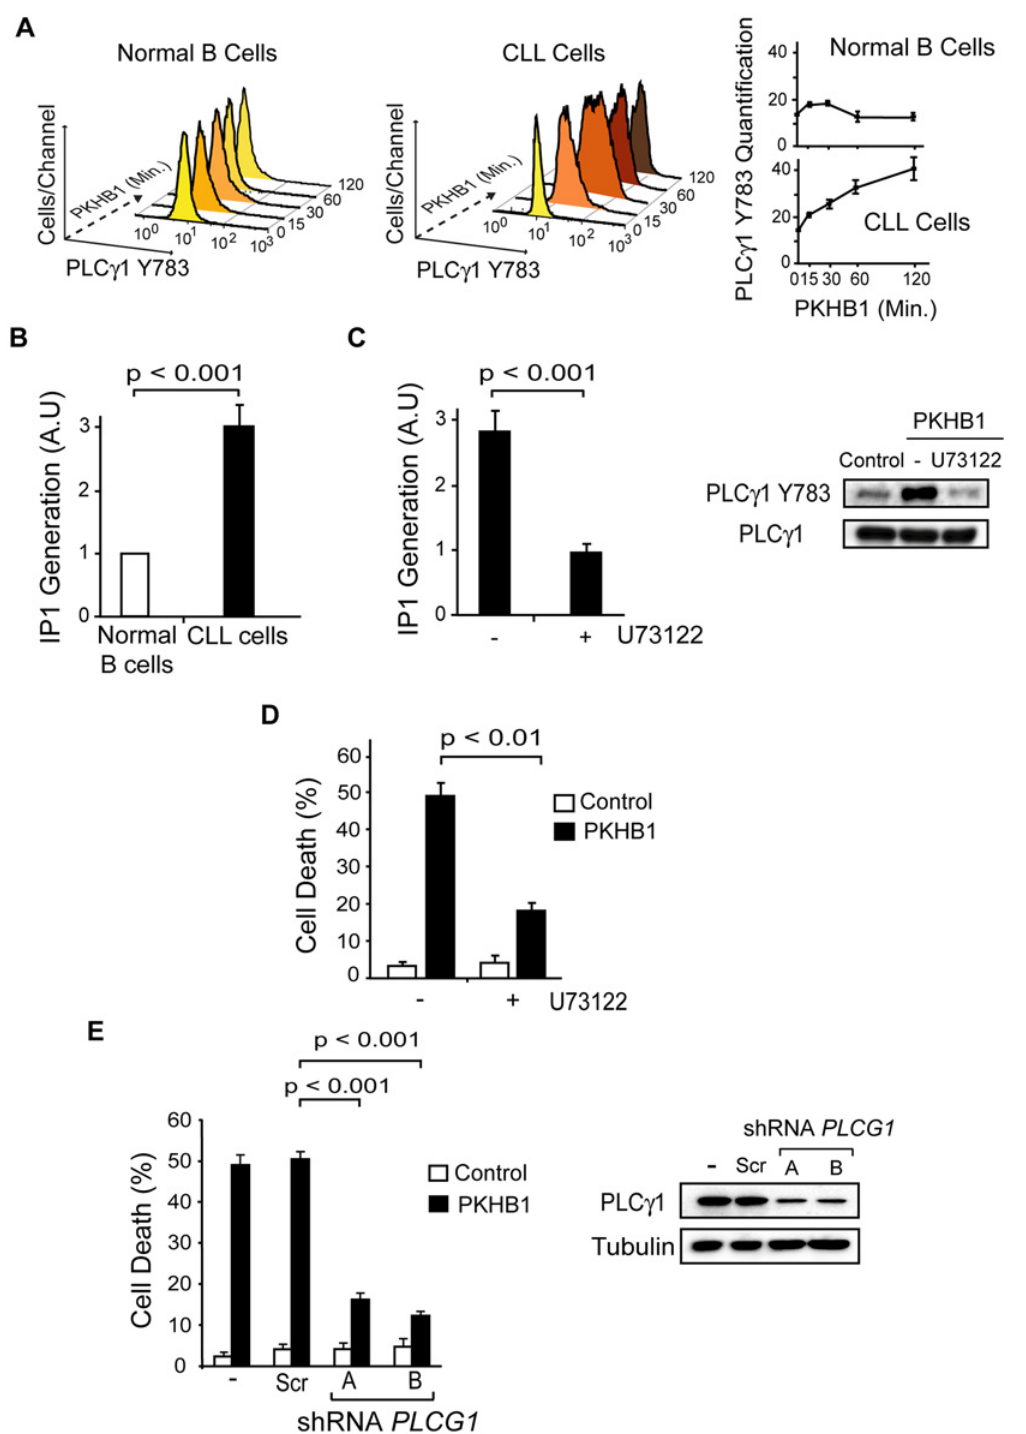
Fig 6. PLC γ 1 controls PKHB1-induced PCD. (A) PLC γ 1-Y783 phosphorylation was detected at different times in the 200- μ M PKHB1-treated normal and CLL B lymphocytes. Representative flow cytometry histograms are shown. In the right panel, the plotted data are presented as MFI ± SD ( n = 4). (B) IP 1 was quantified in 200- μ M PKHB1-treated normal and CLL B cells at 2 h. The histogram depicts mean ± SD ( n = 7). (C) IP 1 generation was determined in 200- μ M PKHB1-treated CLL B lymphocytes pre-incubated with vehicle or the PLC inhibitor U73122. The data in the plot are mean ± SD ( n = 5). Immunoblot analysis confirmed that U73122 inhibited PLC γ 1-Y783 phosphorylation in PKHB1-treated cells (200 μ M, 2 h). Equal loading was confirmed by PLC γ 1 probing.